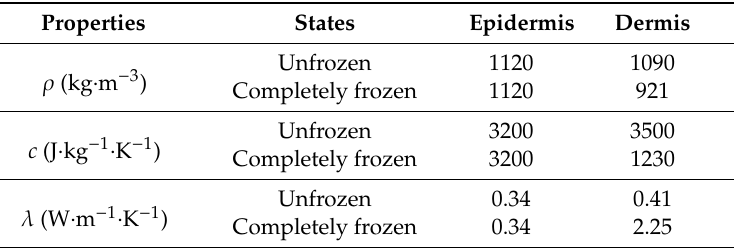
Table 2. Thermal properties of skin components [39].